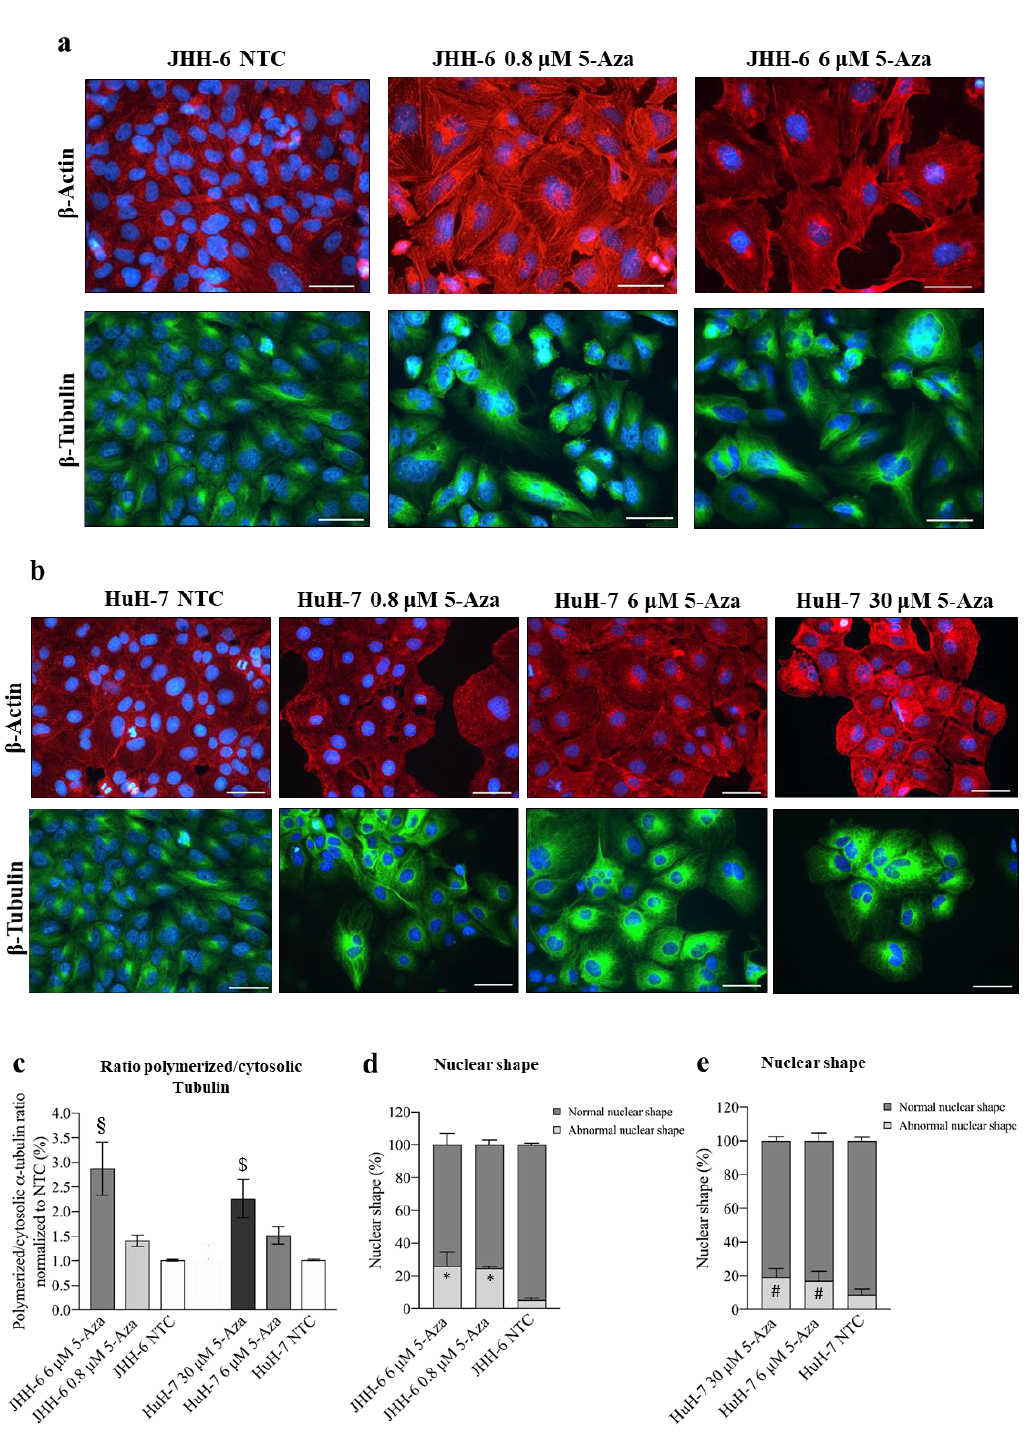
Figure 2. Effects of 5-Aza on cell cytoskeleton. ( a , b ) Immunostaining of β -actin and β -tubulin in JHH-6 and HuH-7 cells, respectively. Images were acquired with a Leica DM 2000 microscope. Red = β -actin; g reen = β -tubulin; blue = DAPI. Magnification 40X (bar = 100 μm). ( c ) Ratio of polymer- ized/cytosolic α -tubulin in 5-Aza-treated vs. non-treated cells (NTC); data are expressed as mean ± SEM; JHH-6 NTC vs. JHH-6/5-Aza, § p = 0.04; HuH-7 NTC vs. HuH-7/5-Aza, $ p = 0.045, n = 3. ( d , e ) Quantification of the number of altered nuclei shape in 5-Aza-treated vs. non-treated cells. Data, expressed as mean ± SEM, are reported as percentage normalized to the average of non-treated cells (NTC). Abnormal nuclei in JHH6/NTC vs. JHH6/0,8- 6 μM , * p < 0.0001 n = 60; HuH7/NTC vs. HuH7/6-30 μ M, # p < 0.001 n = 60.